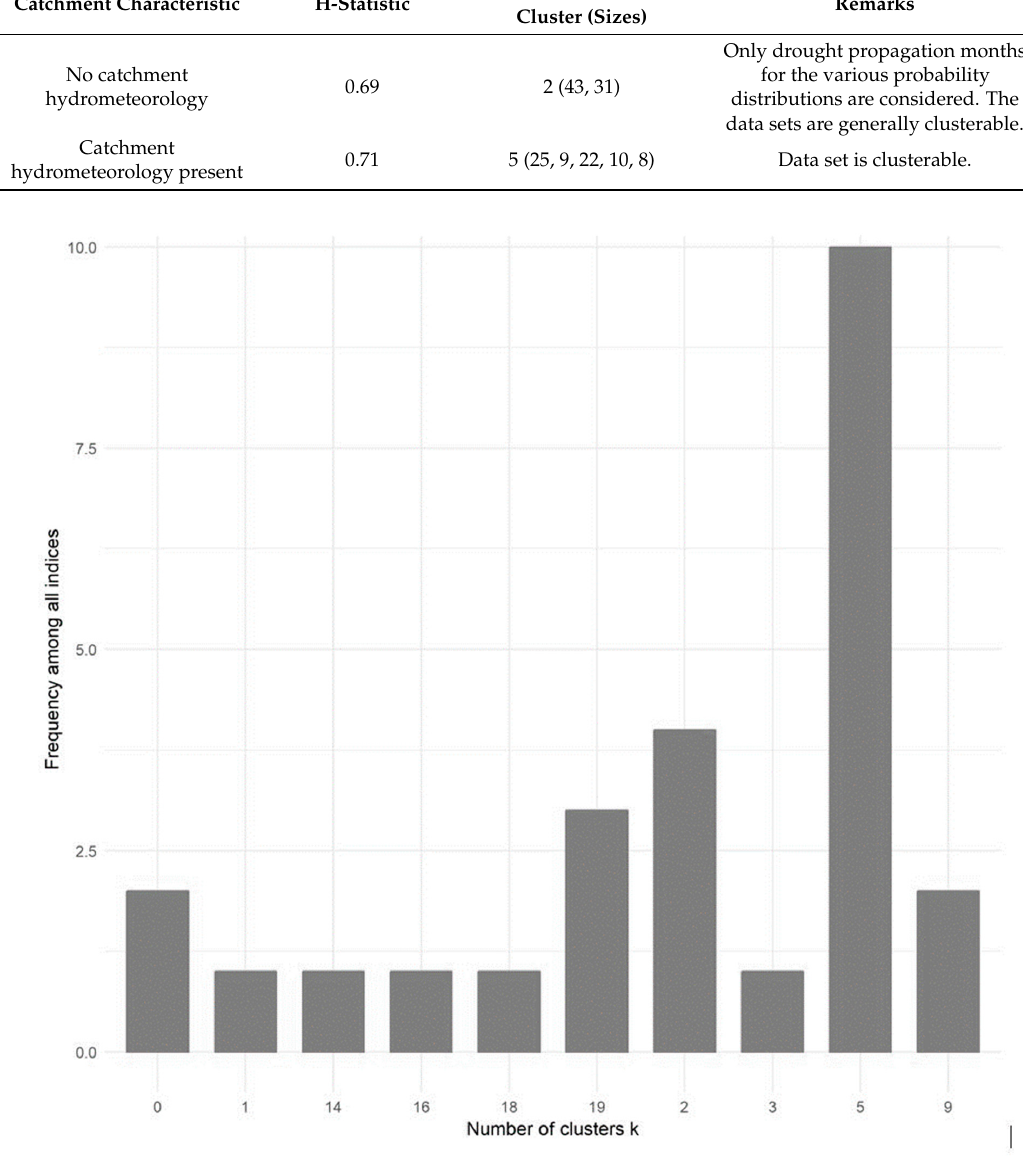
Figure 11 . The optimal number of clusters. Figure 11. The optimal number of